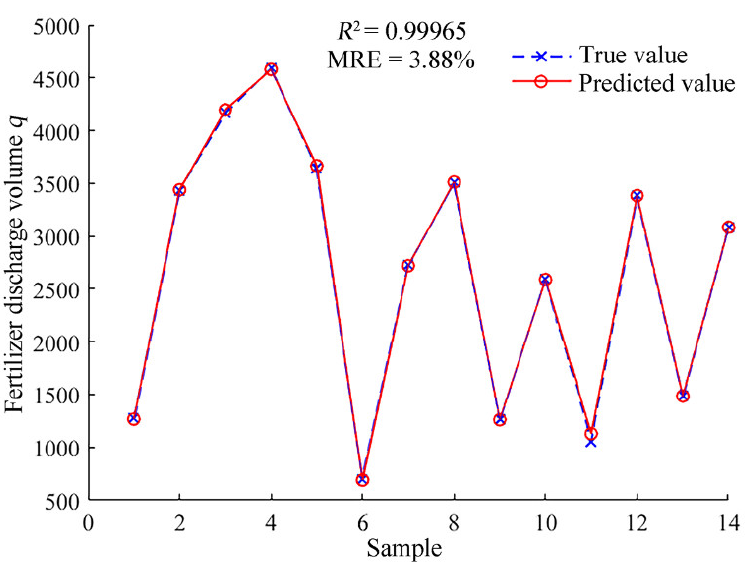
Figure 4. Comparison of predicted fertilizer discharge